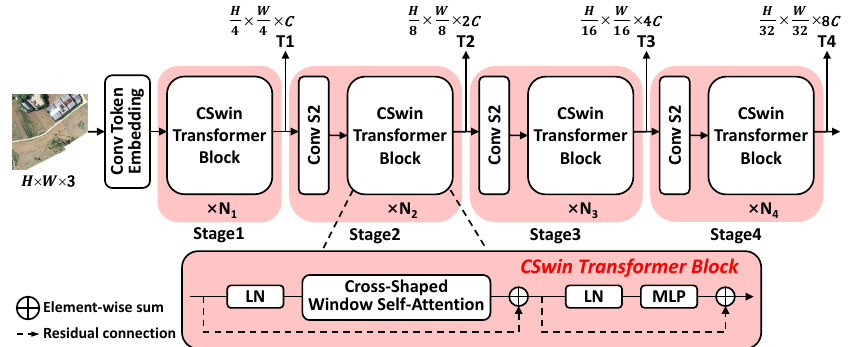
Figure 3. The architecture of CSwin